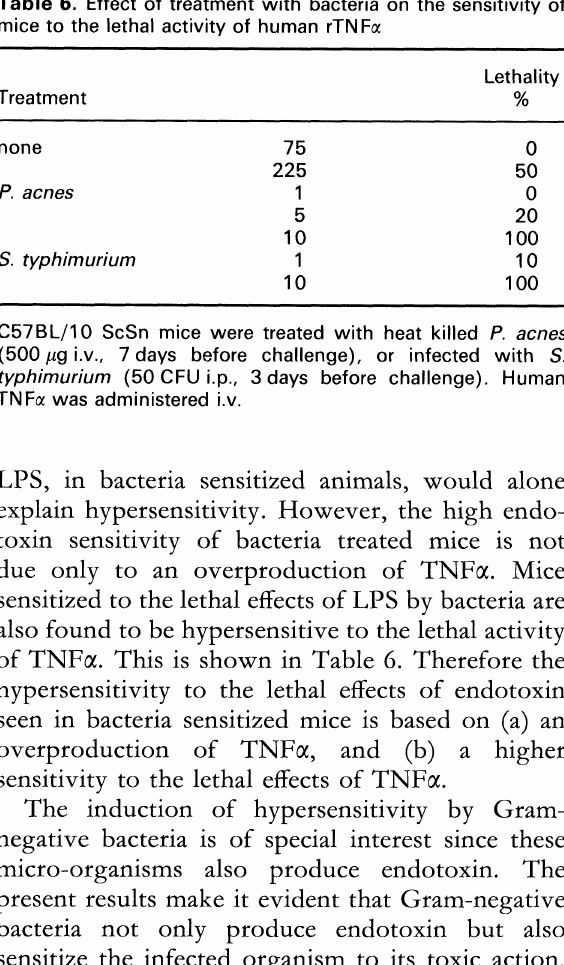
FIG. 3. Effect of anti-IFN on P. acnes induced sensitization to LPS. TNF production.